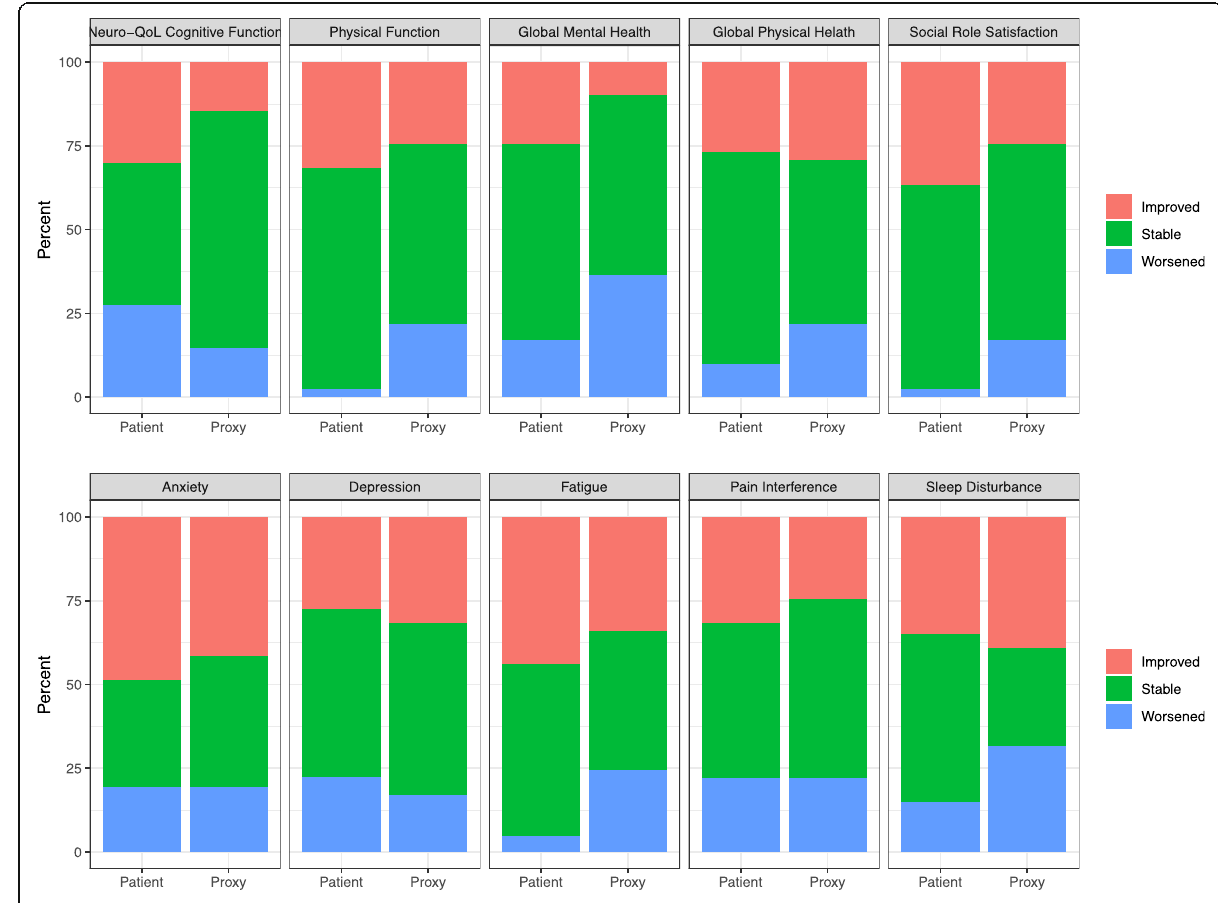
Fig. 1 Comparison of change by patient/proxy report between all patient-proxy dyads, n = 41. Improved = improvement of 5+ T-score points; Worsened = worsening of 5+ T-score points; Stable = change within 5 T-score points